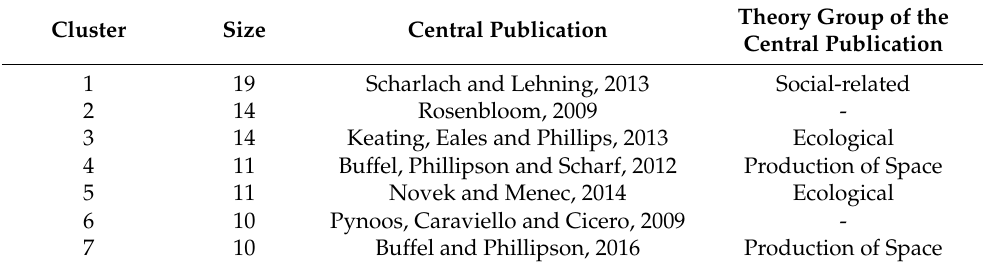
Table 4. Seven largest publication clusters of age-friendly community studies.